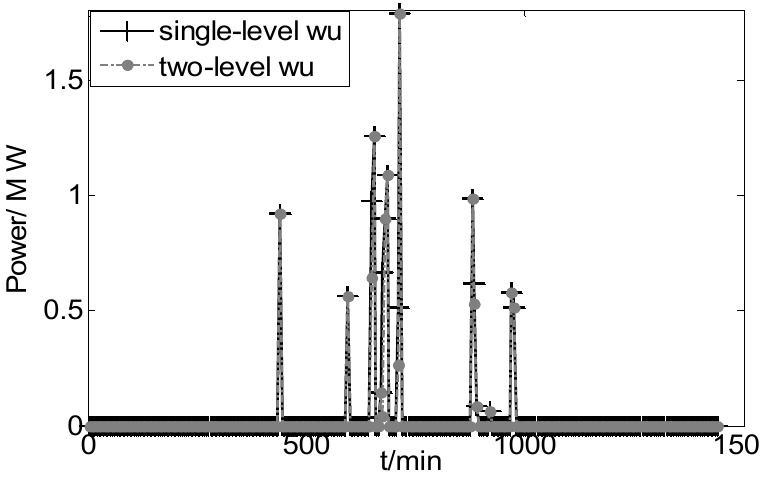
Figure 10. Simulation result for the second sub-objective.